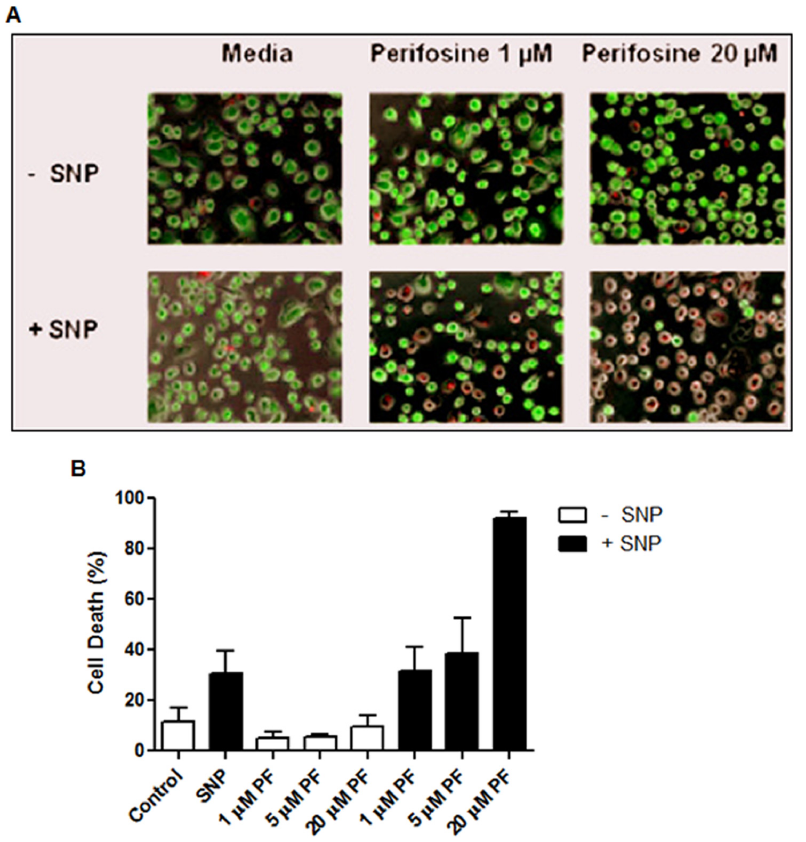
Figure 5. Anti-cytoprotective activity of perifosine in HIV-1 infected primary human macrophages. Primary human monocyte-derived macrophages isolated from blood donors were infected with HIV-1 Bal at MOI 5, and cultured for 12 days in the presence and absence of sodium nitroprusside (SNP, 100 m M) and/or several concentrations of perifosine. Note that 100 m M SNP induces nearly 95% death of uninfected human macrophages [5]. ( A ) Cells were stained with ethidium homodimer and calcein to distinguish between dead (red) and live (green) cells, respectively, on day 12. Images were taken with a fluorescence microscope, and the images shown (merged bright, red, and green fields) are representatives of 3 experiments conducted in duplicate. ( B ) Percent cell death was determined by counting dead and live cells. The values are averages of the duplicates for all conditions performed with macrophages isolated from three separate healthy blood donors. C: infection with no treatment, PF: perifosine.